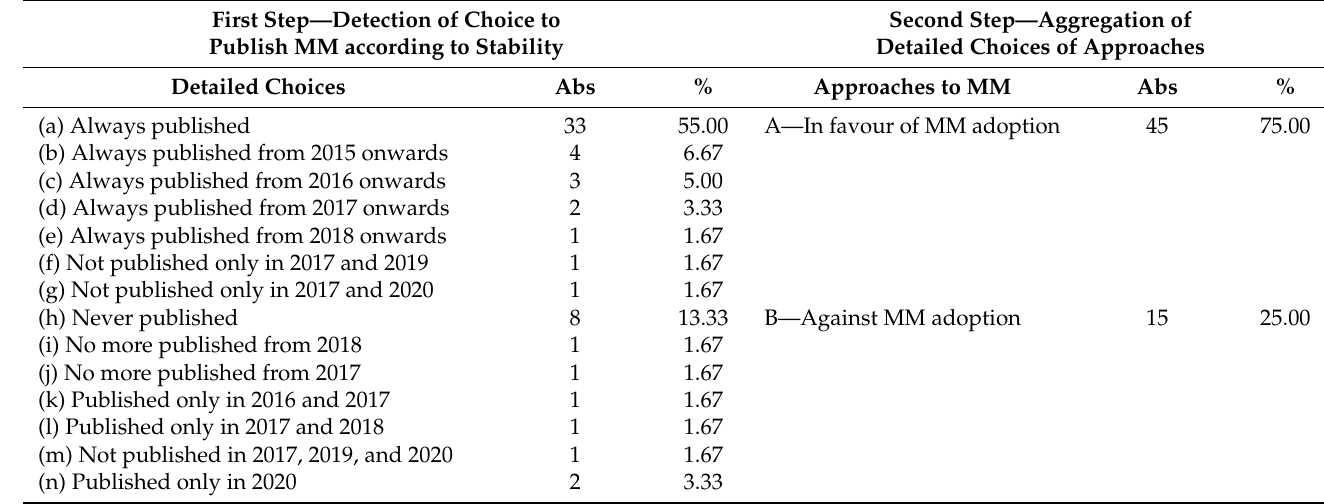
Table 6. Main approaches to MM publishing in 2014–2020 non-financial reports: steps.